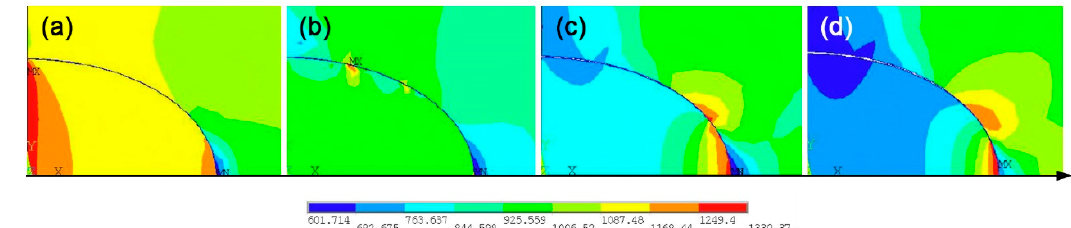
Figure 12. Interface stress field evolution of specimen No. 2: ( a ) Before crack initiation. ( b ) After crack initiation. ( c ) Crack propagation stage. ( d ) Complete debonding of the interface.